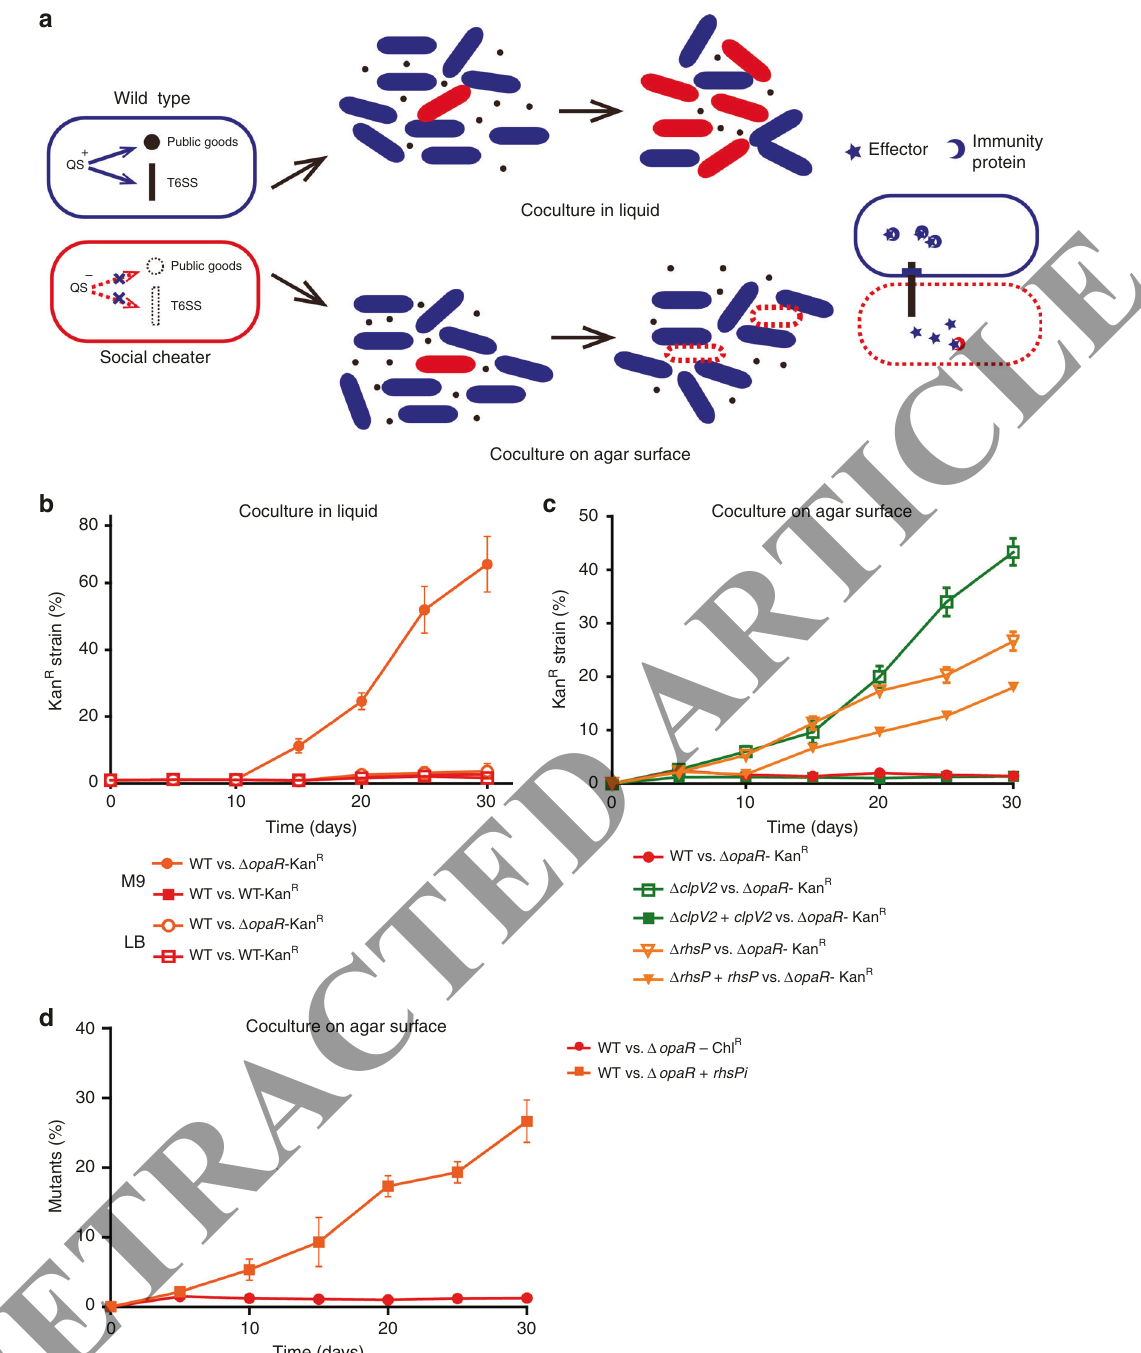
Fig. 5 V. parahaemolyticus deploys T6SS2 and RhsP to restrict the proliferation of social cheaters. a Schematic model of the bacterial policing mechanism with T6SS. QS + (the co-operator, blue cells) produces public goods (black dot) together with T6SS while QS − (the social cheater, red cells) does not. The fi tness cost of QS + leads to the outcompeting of QS + by QS − when cocultured in broth media, in which bacteria will not contact. However, as OpaR positively regulates T6SS2 as well as its toxic pro-effector RhsP/immunity protein RhsPi, QS − produces much less amount of RhsP C and RhsPi than QS + . The competing between QS + and QS − in cocultures on an agar surface will lead QS − to receive excessive amount of RhsP C than its RhsPi can neutralize, and QS − cells will be killed by the immunity-protein-binding-free RhsP C (died QS − cells in red dash line). b V. parahaemolyticus QS − ( Δ opaR ) outcompetes wild-type (WT) (QS + ) when grown in broth minimum media with casein as sole carbon source but not in LB medium. c V. parahaemolyticus restricts social cheater ( Δ opaR ) by a functional T6SS2 and RhsP. When cocultured on the M9 agar plate, the growth advantage of Δ opaR was compromised. Mutations in T6SS2 ( Δ clpV2 ) or the pro-effector ( Δ rhsP ) compromised the capability of bacteria to restrict the proliferation of social cheater ( Δ opaR ). d RhsPi protects social cheater ( Δ opaR , QS − ) from being killed by WT (QS + ). Δ opaR expressing RhsPi was cocultured with the WT (QS + ) on the M9 agar plate. For b and c , the starting abundance of strains resistant to kanamycin (kan R ) is 1%. For d , the starting abundance of Δ opaR- Chl R and Δ opaR + rhsPi is 1%. For b , c , and d , the values represent the means ± s.d. from one representative experiment performed with triplicate samples. Equivalent results were obtained at least three